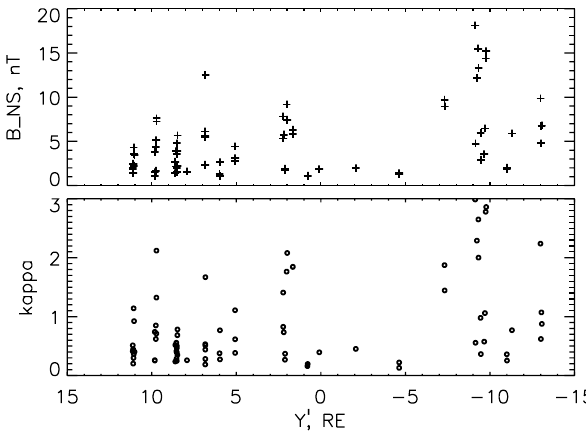
Fig. 11. Distributions of the median magnetic field in the neutral sheet B NS (upper panel) and the adiabaticity parameter κ (bottom panel) versus Y 0